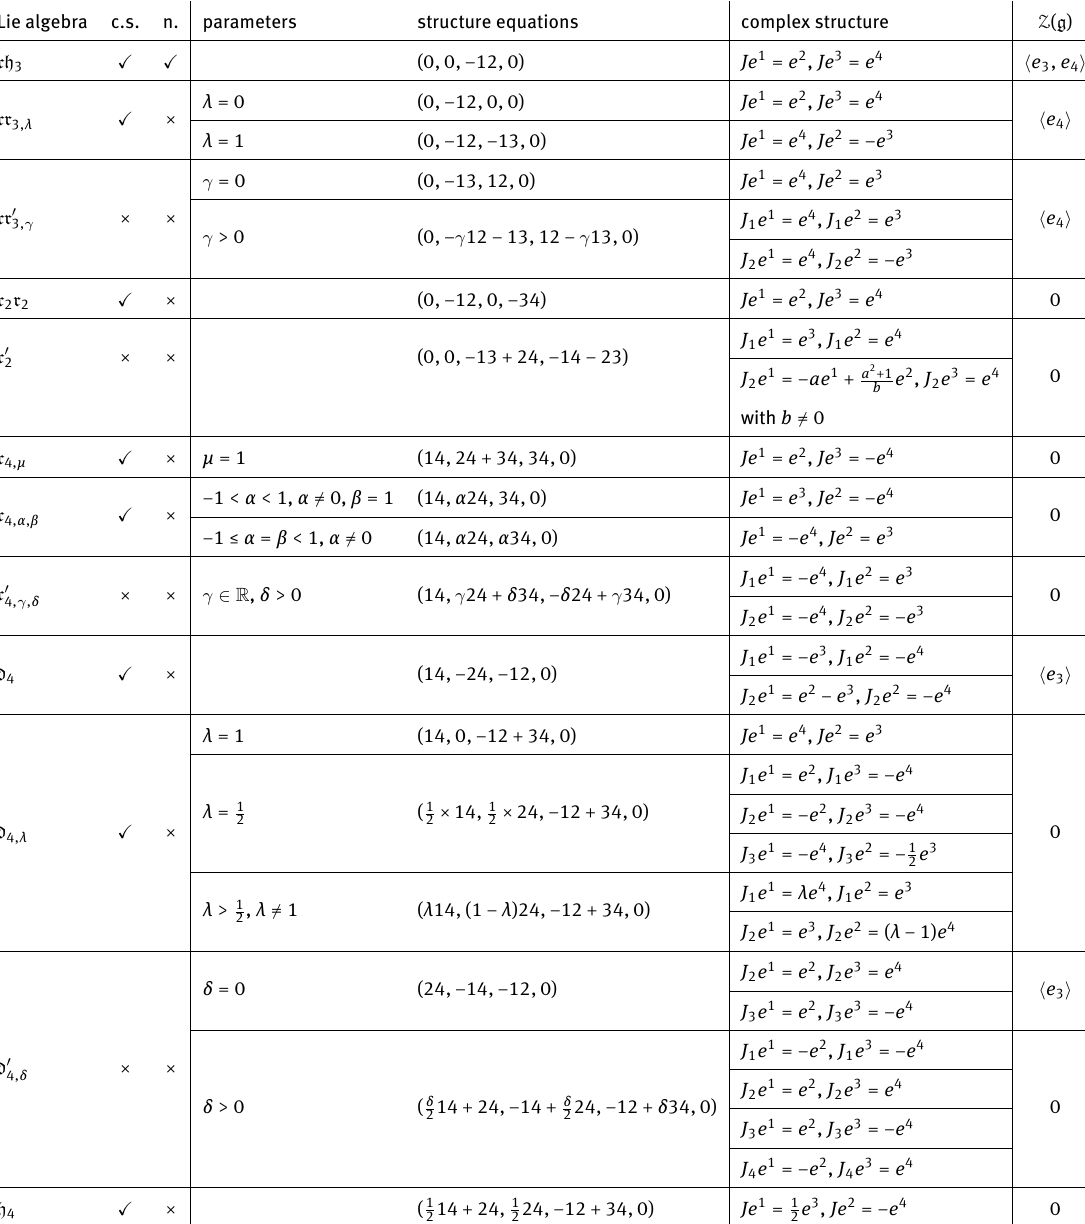
Table 1: Complex non-Kähler structures on solvable Lie algebras in dimension 4 up to linear equivalence, following [32]. ("c.s." is for "completely-solvable", "n." is for "nilpotent", and Z denotes the center.) Lie algebra c.s. n.